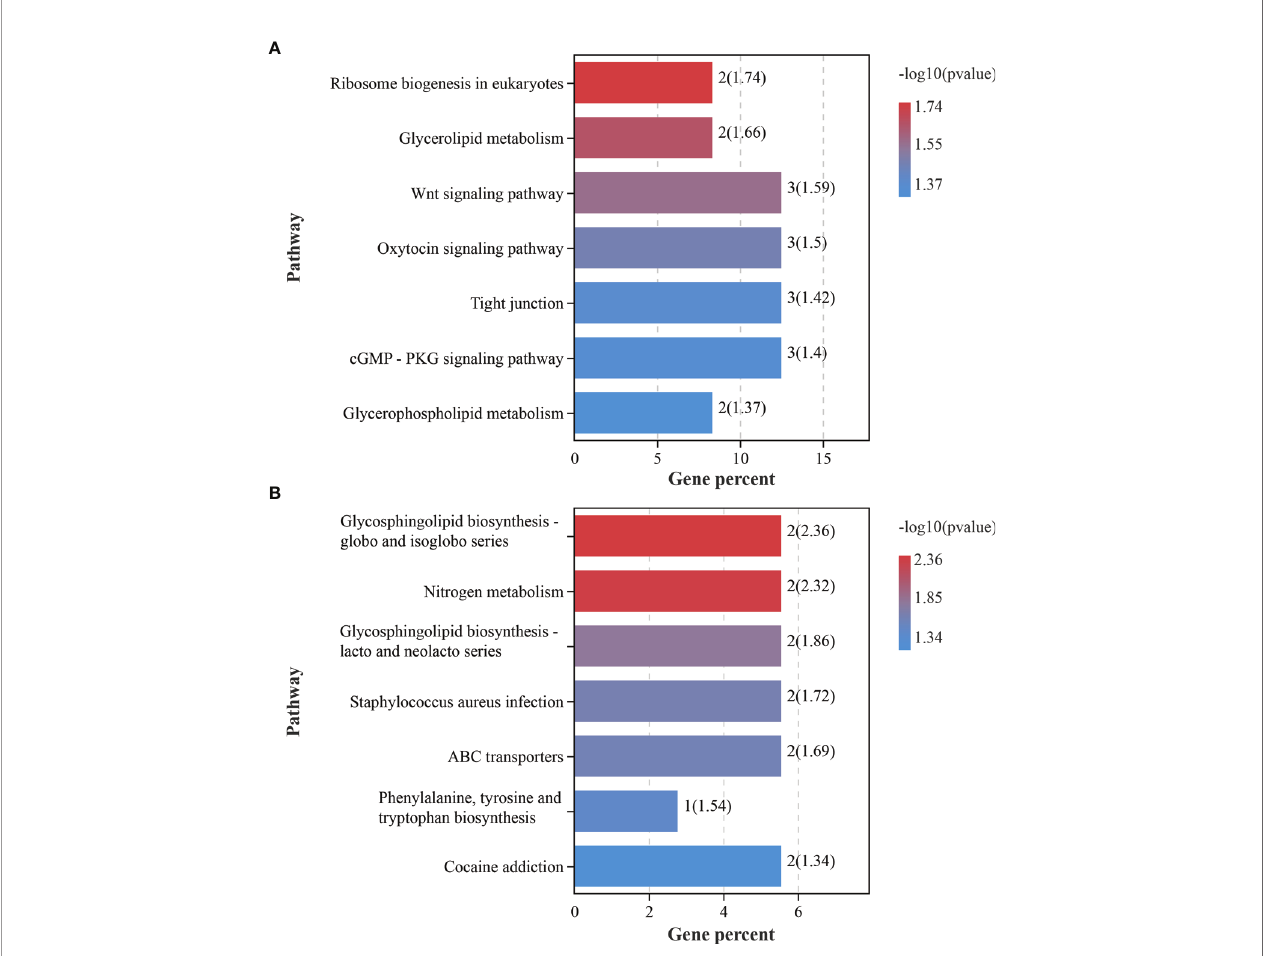
FIGURE 5 | Kyoto Encyclopedia of Genes and Genomes pathway analysis of the differentially expressed circular RNA (circRNA) host genes (A) and mRNAs (B) involved in the competing endogenous RNA (ceRNA)